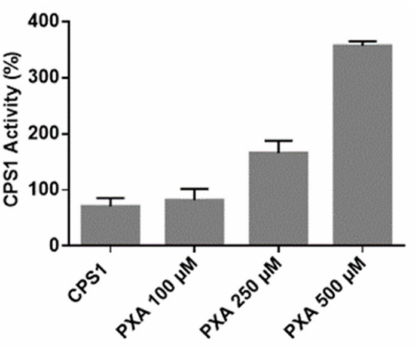
Figure 4. CPS1 activity measured as reported above in presence of di ff erent PXA concentrations. The data are shown as a percentage of CPS1 activity. The experiments have been repeated three times, and S.D. has been calculated. Opportune controls were carried out as the measurement of the signal of PXA alone at di ff erent concentrations (see also Figure